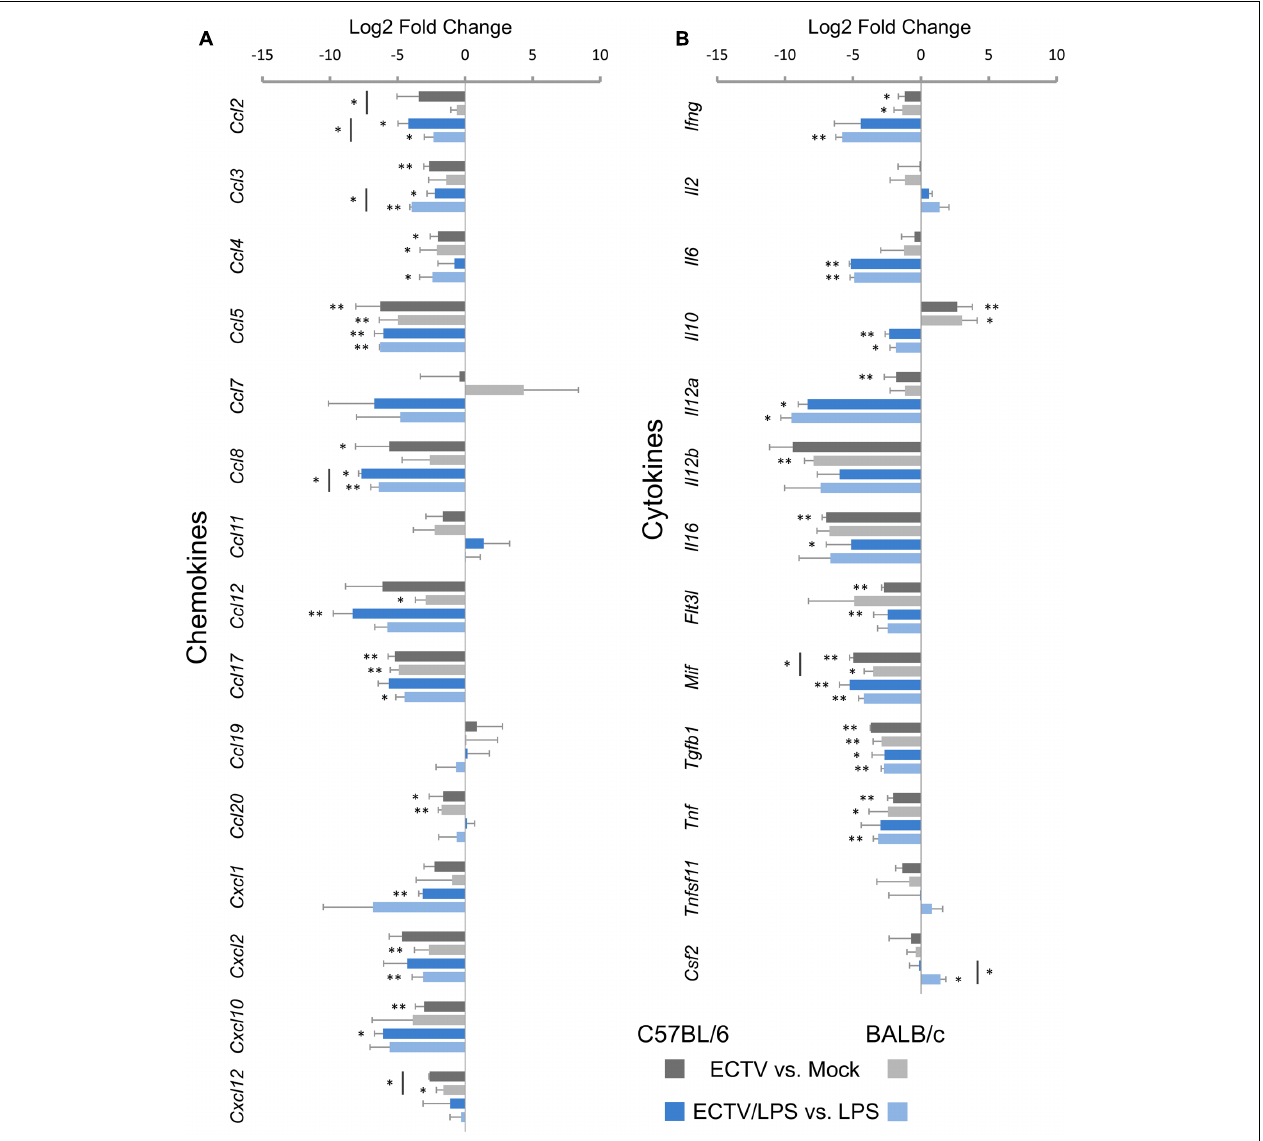
FIGURE 5 | Mouse strain-independent effect of ECTV infection on the expression of genes for chemokines (A) and cytokines (B) in GM-BM (unpaired Student’s t -test; ∗ P < 0.05, ∗∗ P <